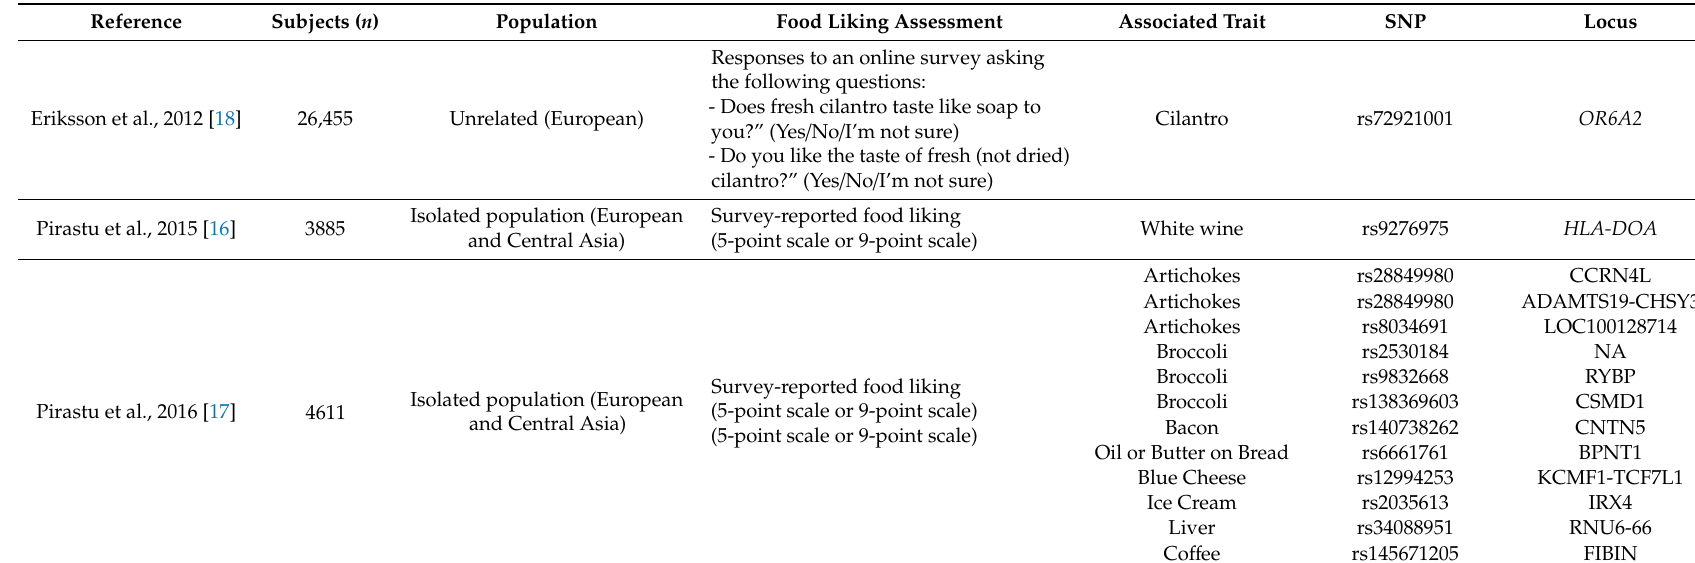
Table 1. GWA studies of food